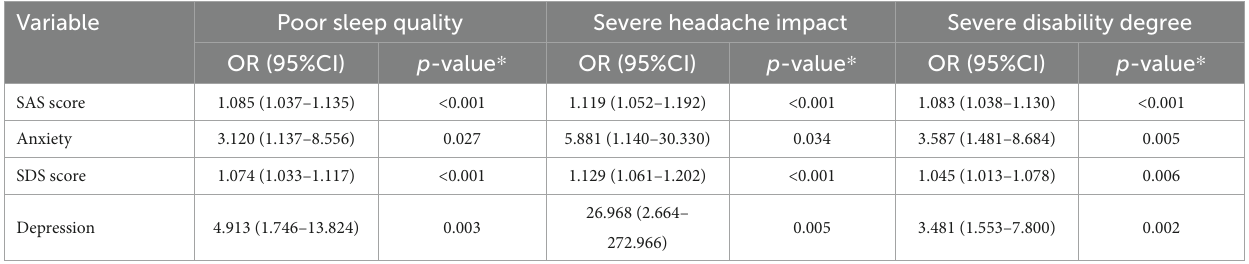
TABLE 5 Effects of anxiety and depression on poor sleep quality, severe disability degree, and severe headache impact in migraine patients. Variable Poor sleep